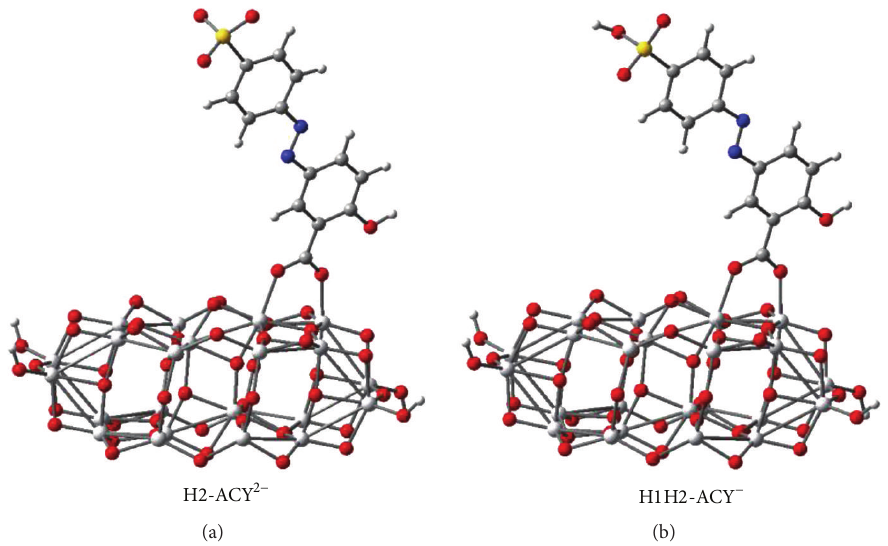
Figure 7: Optimized structure of complex dye-oxide systems with anchoring through the carboxyl group, calculated at DFT/B3LYP/3-21G(d) level.